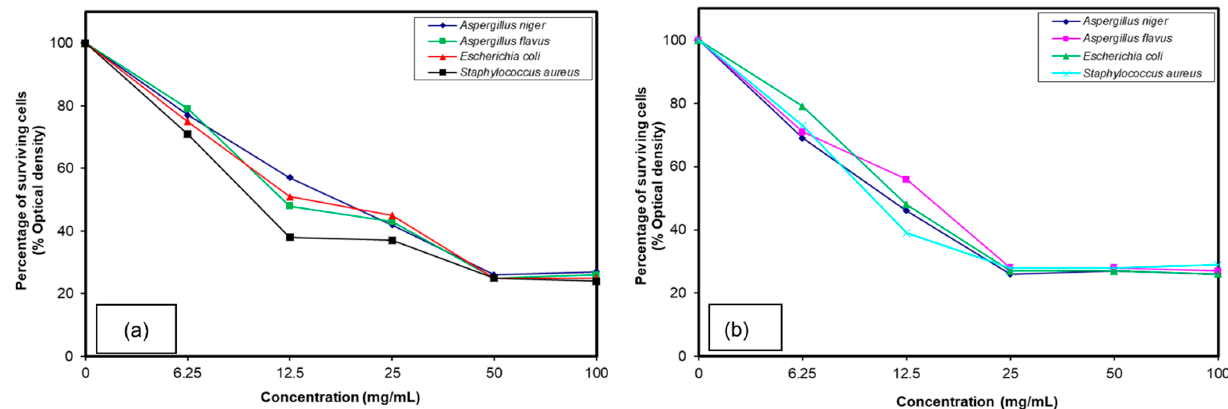
Figure 3. Growth inhibition against the various microorganisms examined of different polymer concentrations ( a ) IV and ( b ) V.